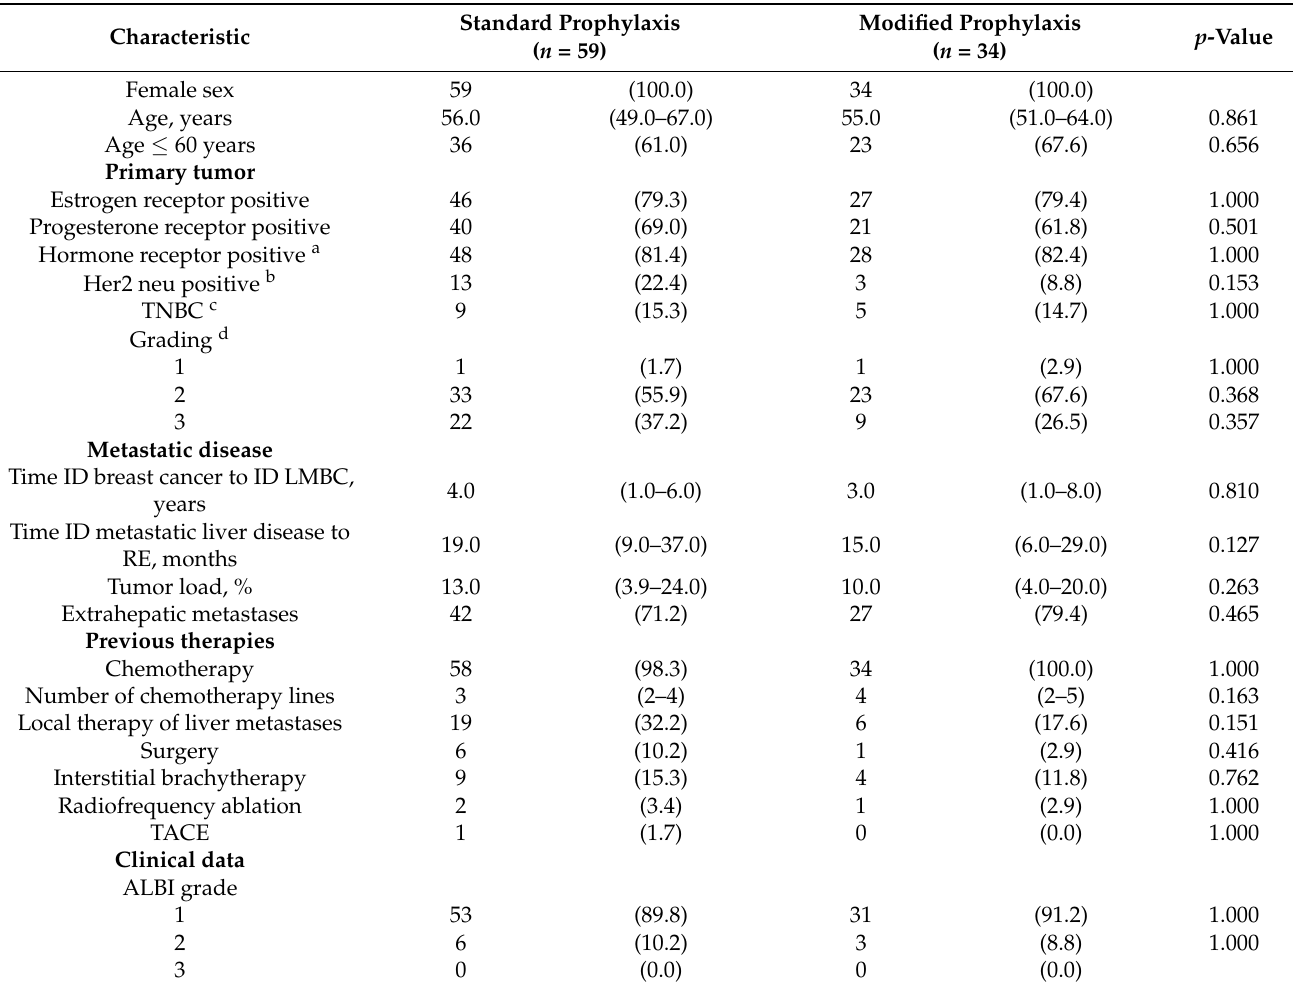
Table 1. Baseline and treatment